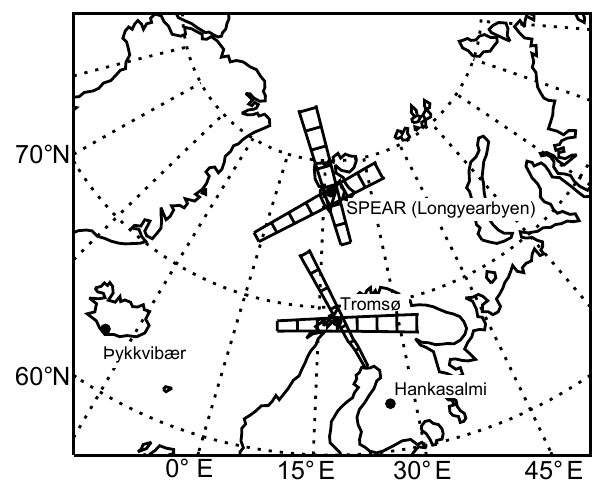
Fig. 1. Beam and range locations for the radar modes used in this study. Range gates are marked every 10th